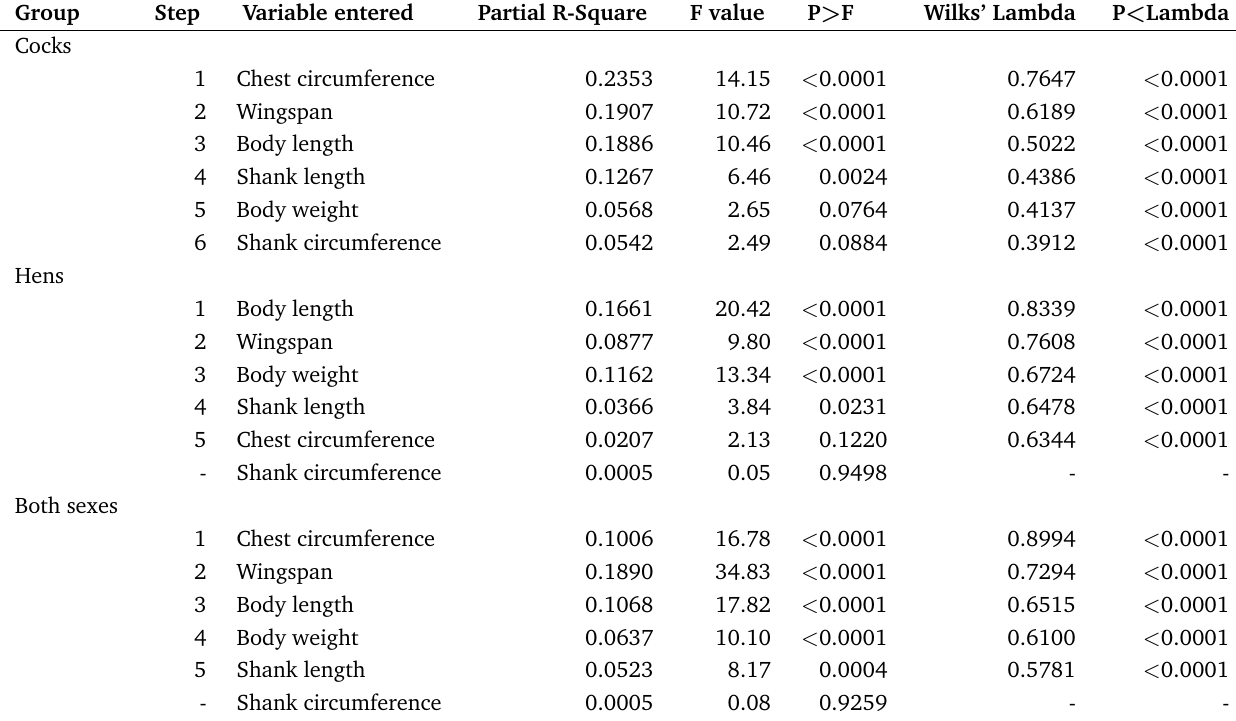
Table 8. Summary of the stepwise discriminant function analysis; ascending order of traits used in discriminating the chicken populations from different districts.